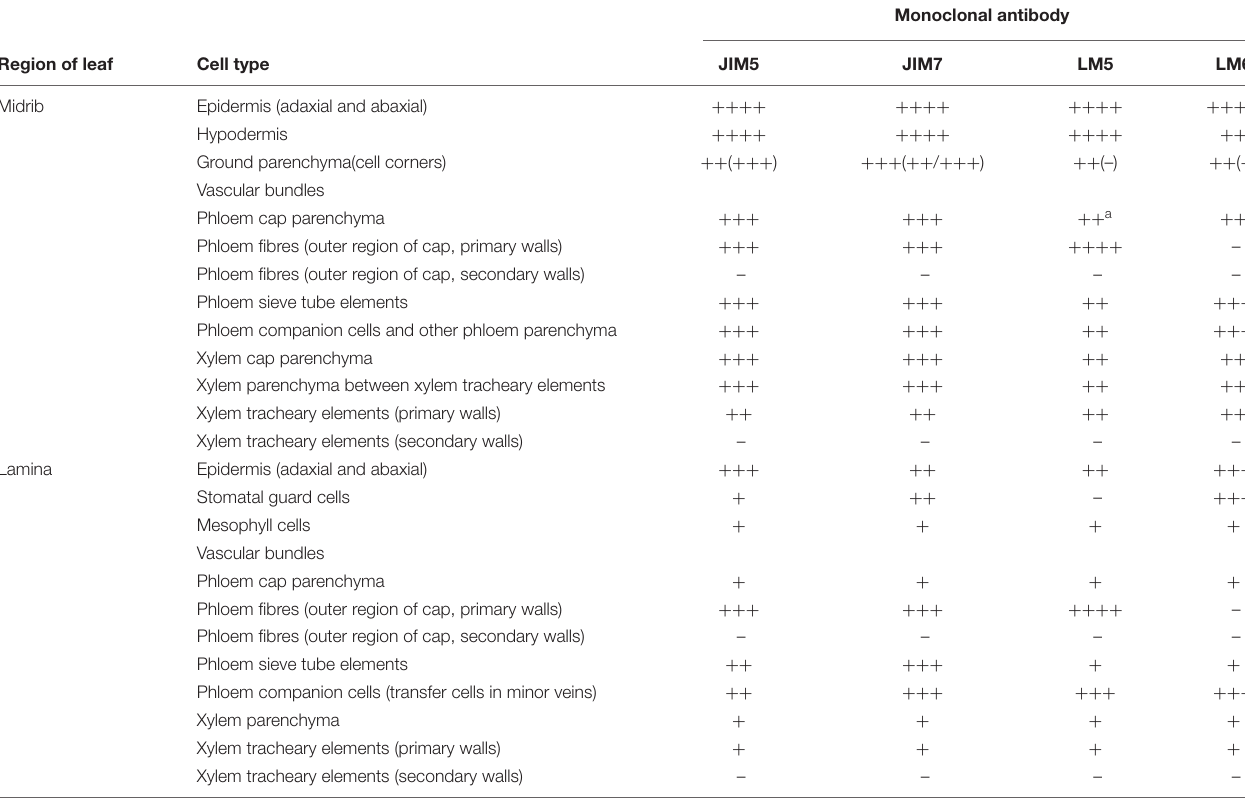
Monoclonal antibody